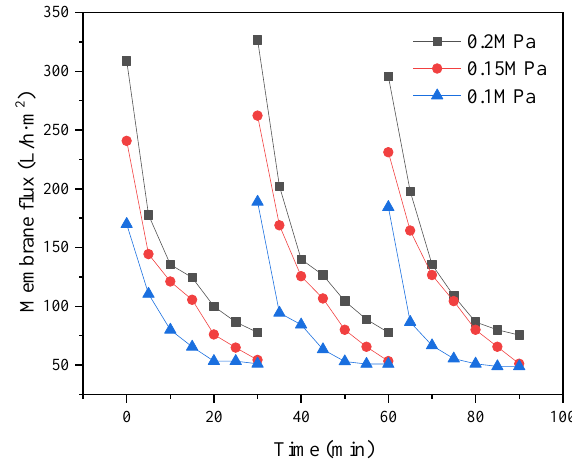
Figure 6. Effect of operating pressure on the membrane flux.